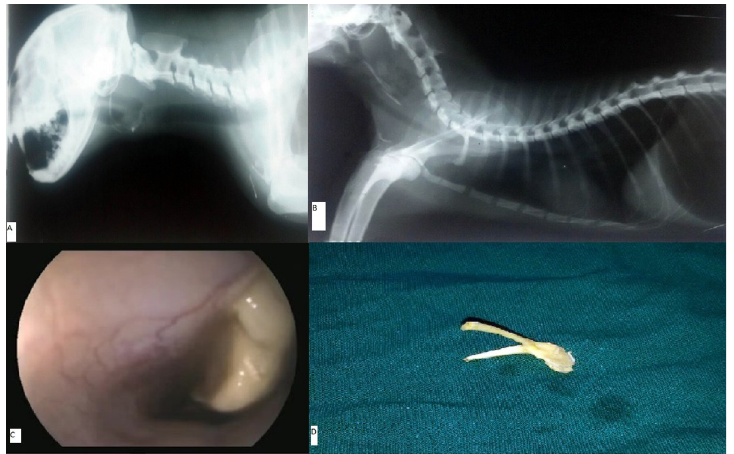
Fig 3. Radiographic and endoscopic views of foreign bodies in the mid-cervical oesophagus. a. Lateral radiographic view showing radiopaque bone structure in the cervical region of the oesophagus. b. Lateral radiographic view showing radiopaque bone fragments in the mid-cervical region of the oesophagus. c. Oesophagoscopy showing bone in the cervical region of the oesophagus. d. Bone after retrieval.